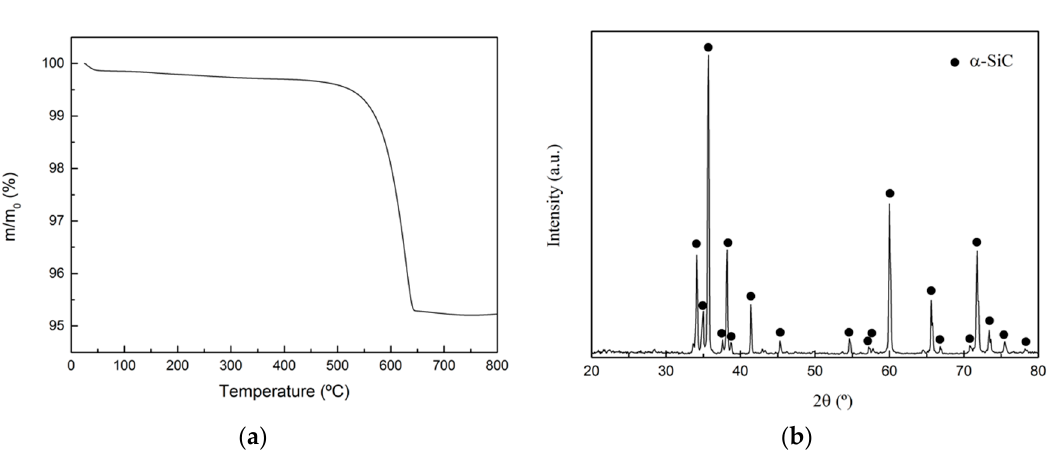
Figure 1. ( a ) Thermogram of the SiC p /C preform in an oxidizing atmosphere (N 2 :O 2 = 4:1); ( b ) XRD pattern for the SiC p /C preform.